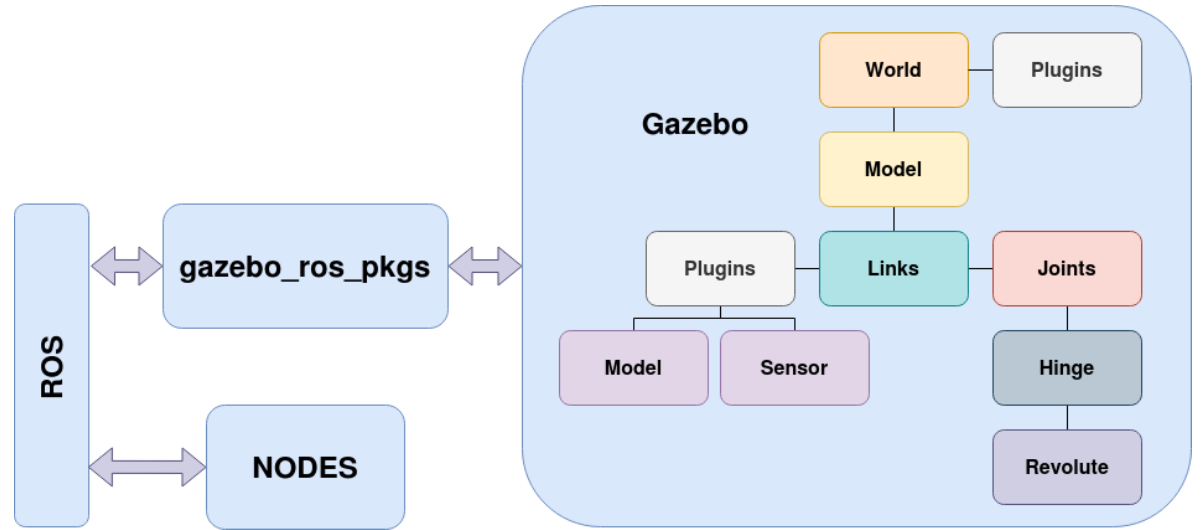
Figure 4. Gazebo-Robotic Operating System (ROS) interface block diagram